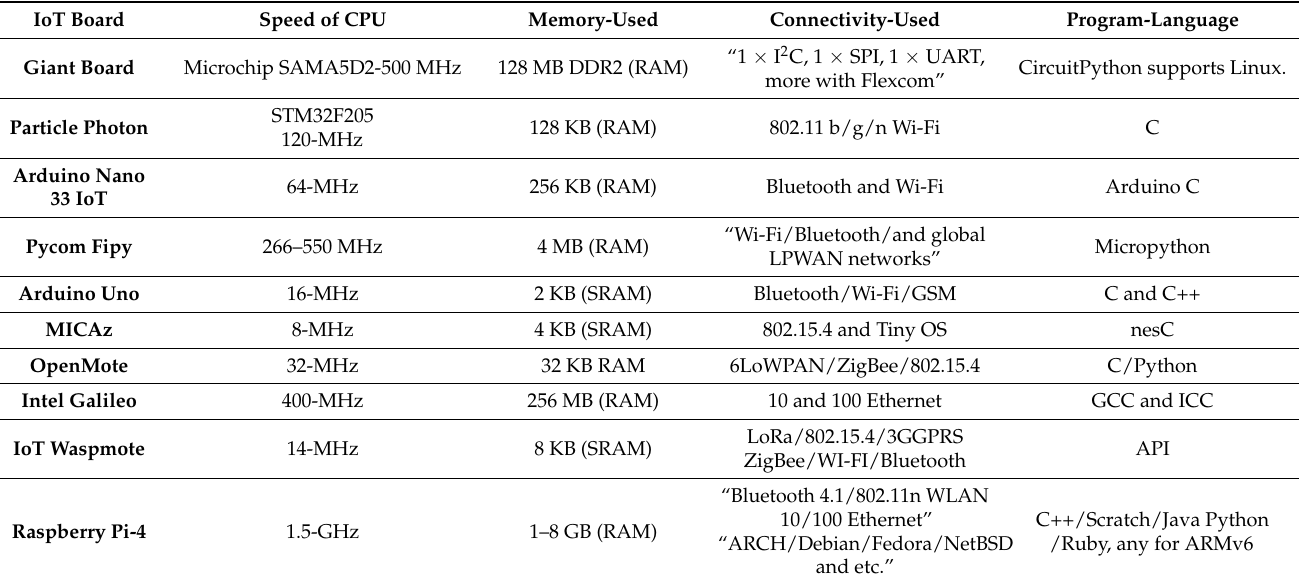
Table 1. Summary of the differences between some of the most common IoT